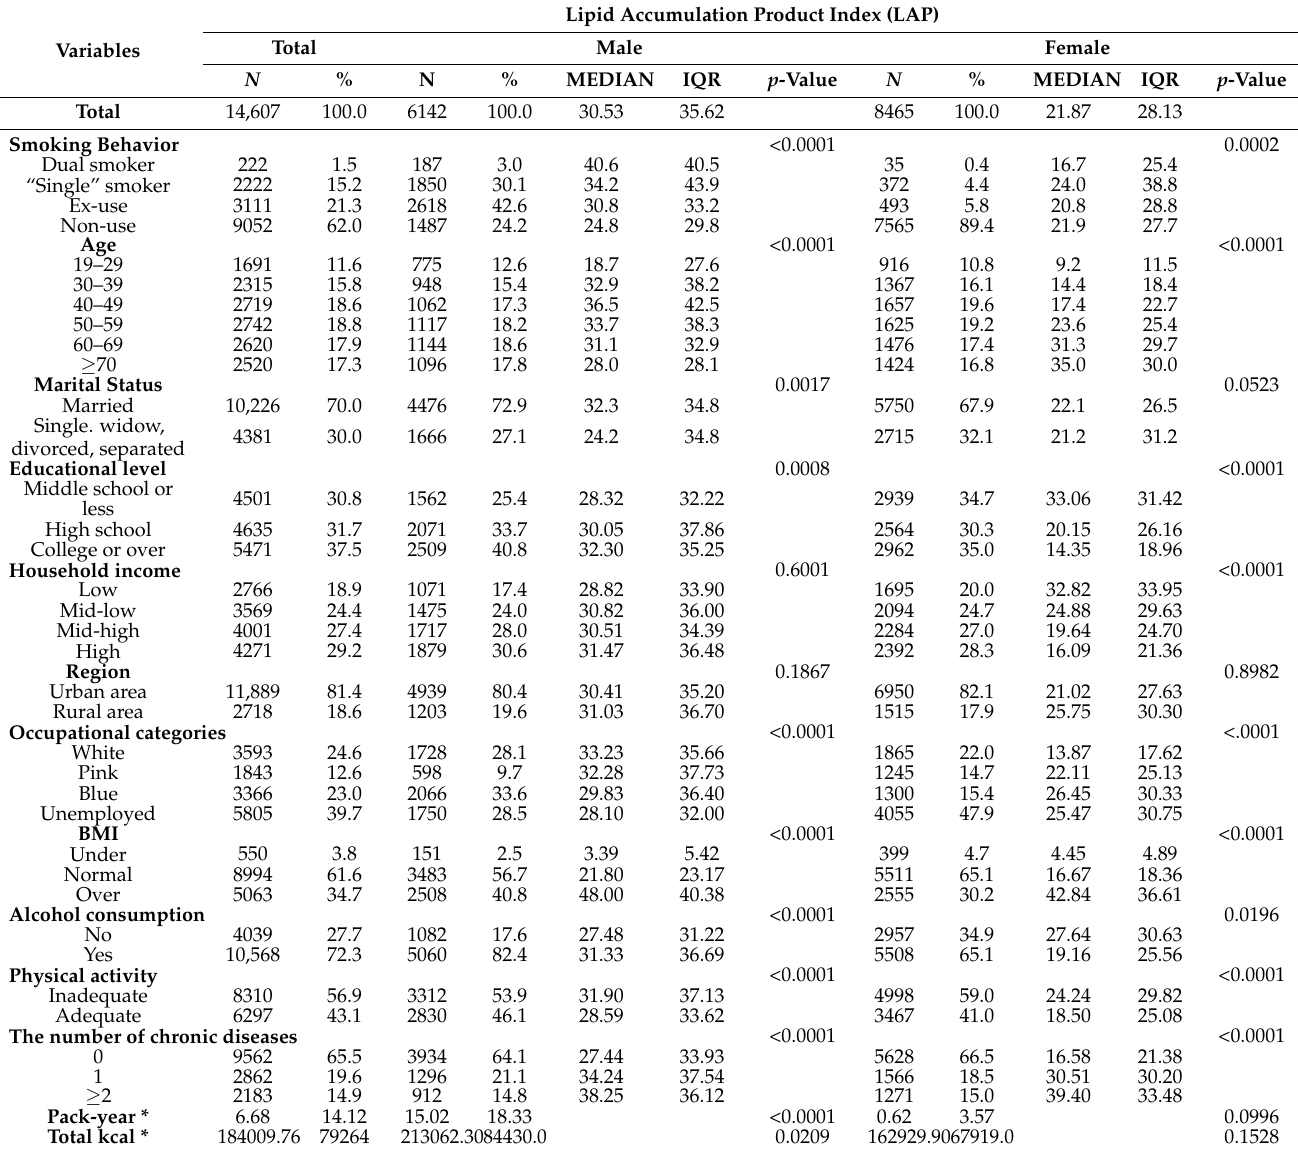
Table 1. General characteristics of the study